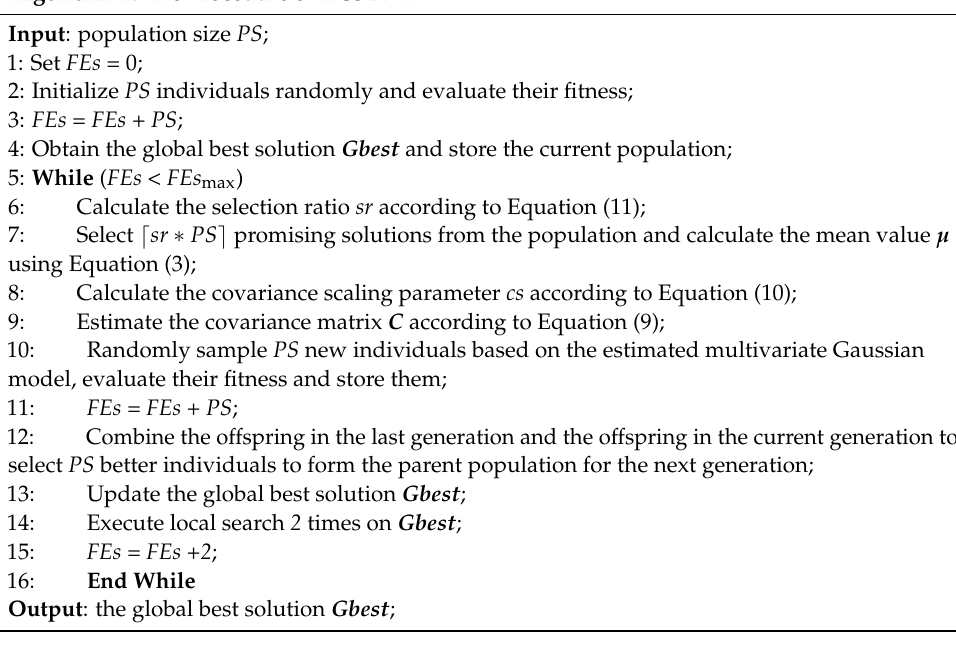
Algorithm 2: The Procedure of